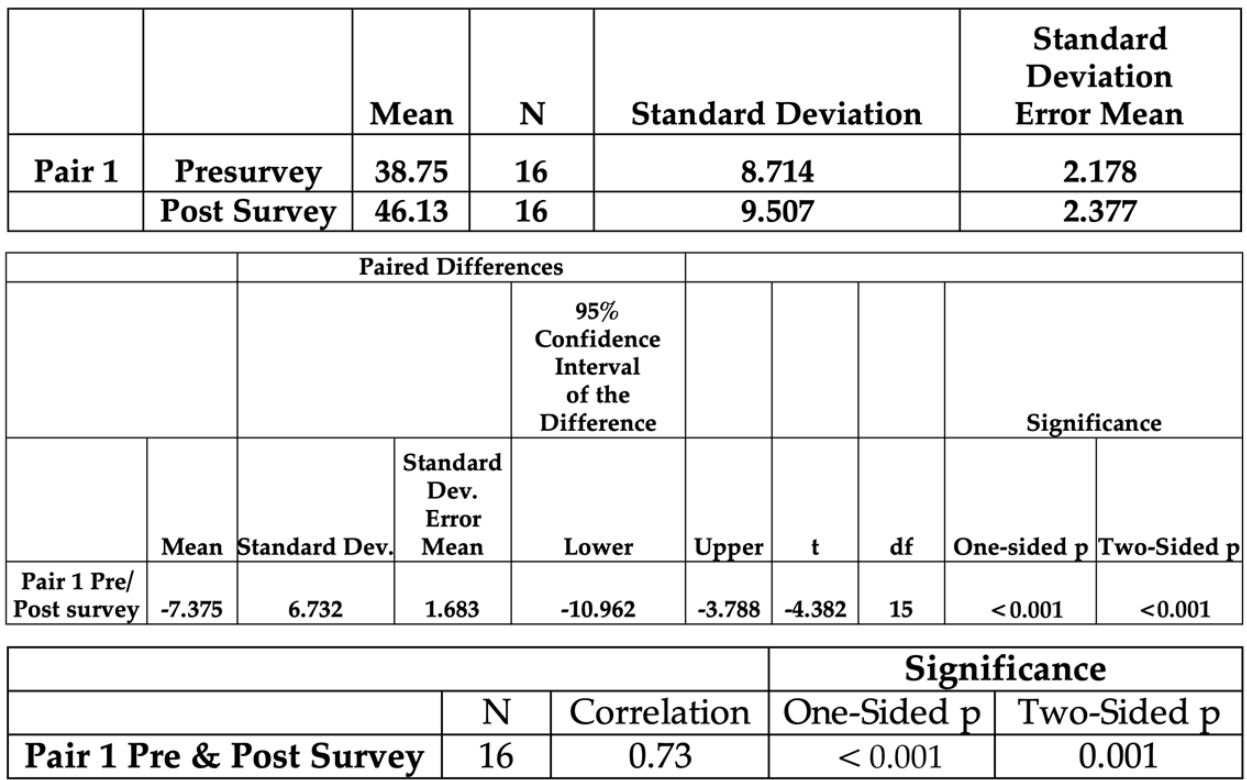
Figure 3. Measurement of individual participant scores.